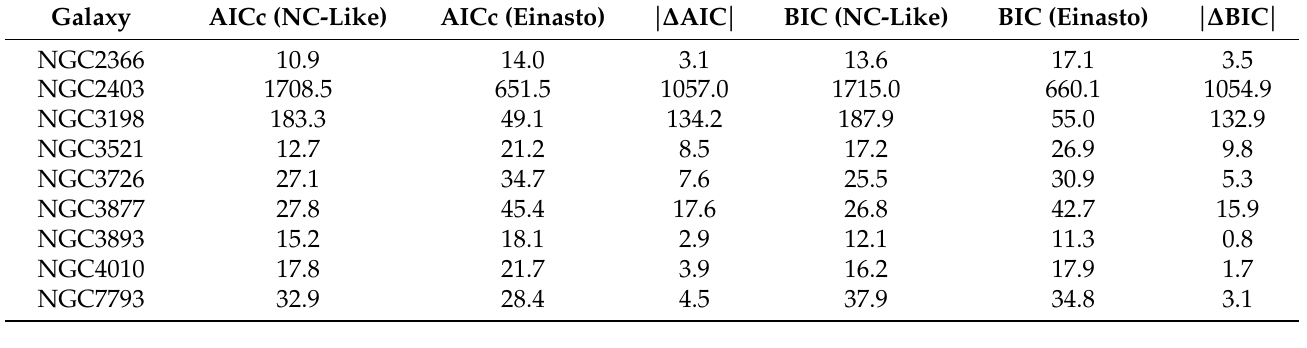
Table 3. Akaike information criterion (AIC) and Bayesian information criterion (BIC) for NC-like and Einasto. ∆ AIC ( ∆ BIC) yield value is the difference between AIC (BIC) model values of AIC for each galaxy.